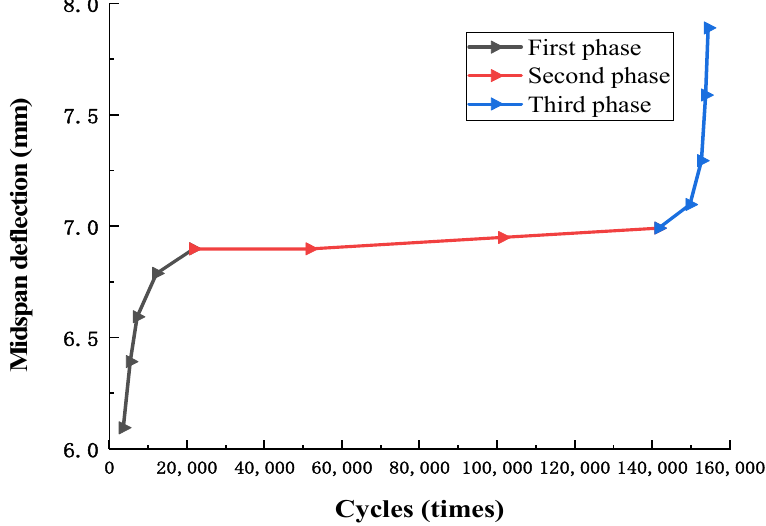
Figure 8. The midspan deflection of the beam with a fatigue life of 152,355 cycles. Figure 8 demonstrates that the midspan deflection of the beam during fatigue loading presents three-phase characteristics. The first phase is the rapid growth of the beam deflection, which accounts for approximately 6.5% of the fatigue life. After that is the